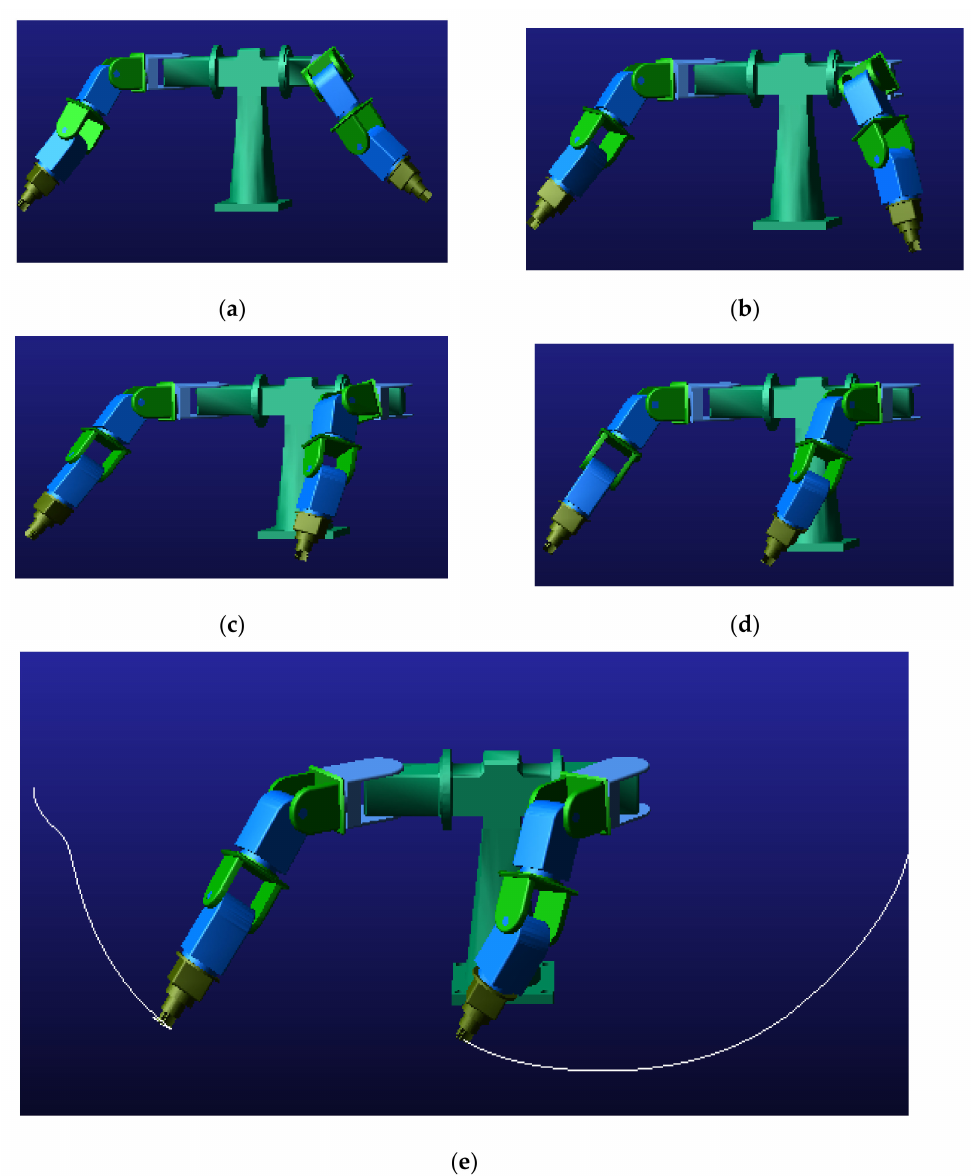
Figure 13. The movement process of dual-arm robot in Adams. ( a – d ) Images representing different states of the dual-arm robot at each moment. ( e ) Image representing the trajectory of each manipulator during